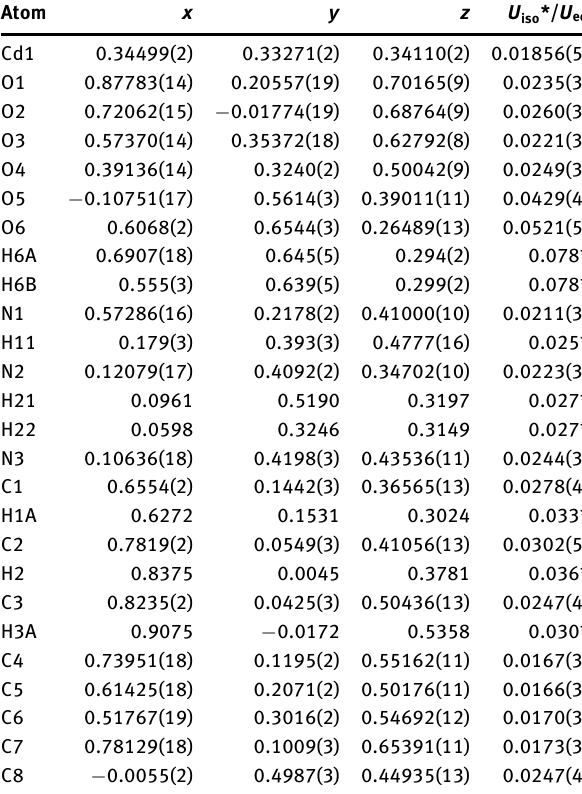
Table 2: Fractional atomic coordinates and isotropic or equivalent isotropic displacement parameters (Å 2 ).